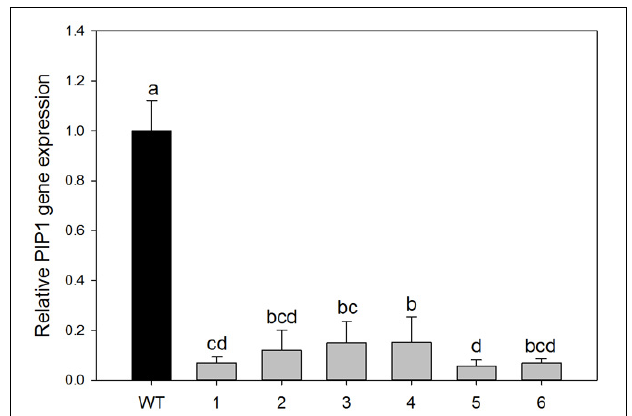
FIGURE 1 | Relative expression of PIP1 genes in the leaves of wild-type and transgenic lines. Each histogram is the average of three independent biological samples with two technical replicates; error bars represent SE. Letters denote homogeneous groups based on the Fisher LSD method corrected for the multiple comparisons. There is a significant difference between relative gene expression in the seven different plant groups (wt and the six transgenic lines, 1–6), ( P < 0 . 001, One Way ANOVA